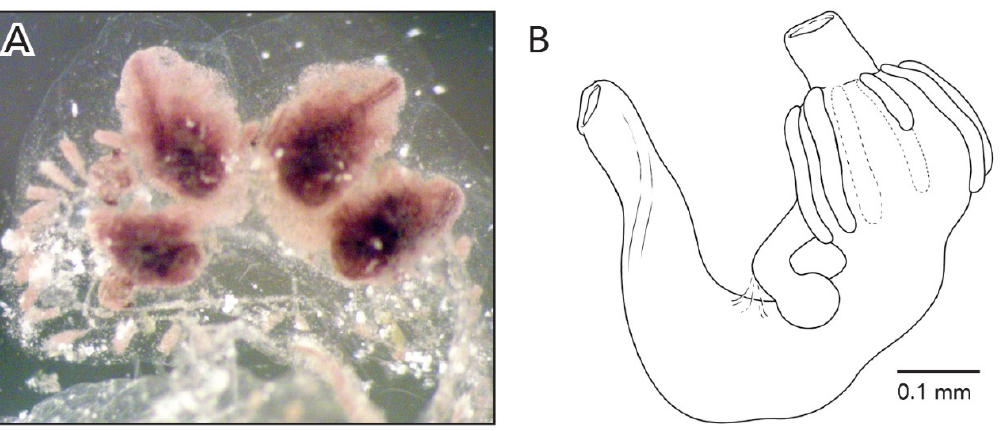
Figure 3. Botryllus bonanzus sp. nov. ( A ) Preserved colony with four visible zooids ( B ) Detail of the abdomen region.